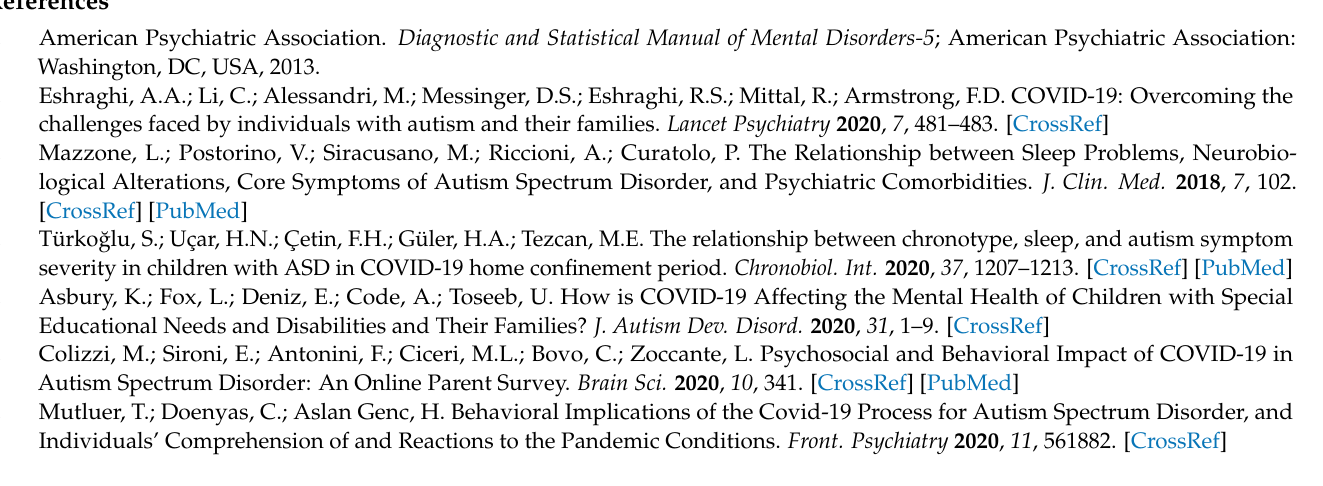
7/8/2/96/s1, Table S1: Study Protocol, Table S2. Strobe Checklist, Table S3: ABAS-II, CBCL and RBS subscales scores at T0 and T1 in preschooler and schooler